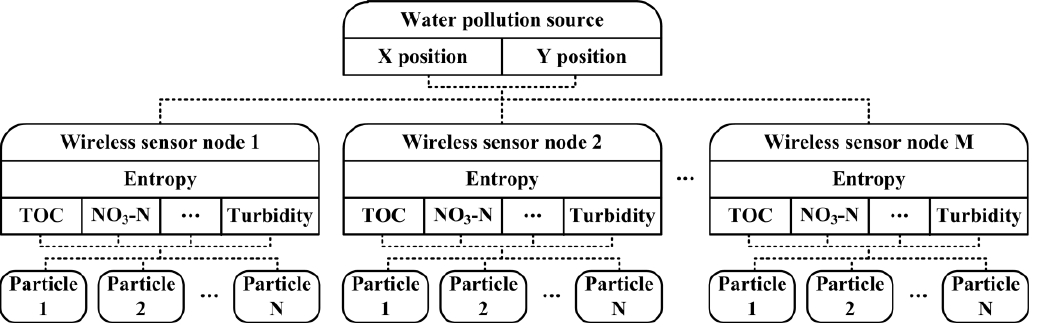
Figure 6. The diagram of the Dual-PSO algorithm.